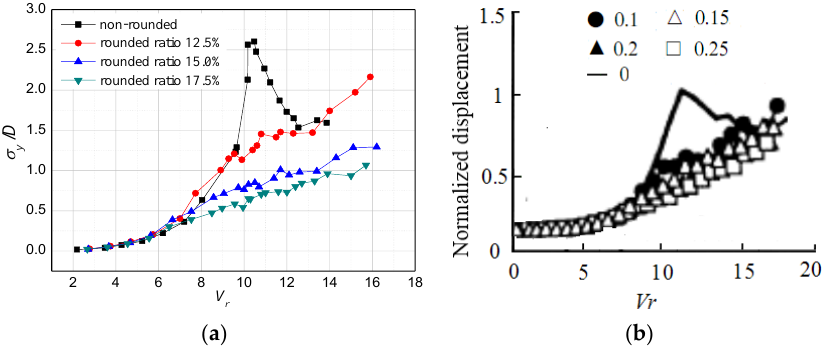
Figure 12. Crosswind responses of models with different rounded ratios: ( a ) RMS responses of this study; ( b ) RMS responses of SDOF model result [13].